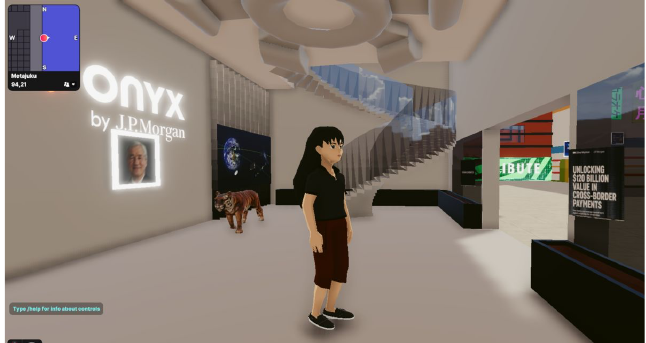
Figure 35: JP Morgan in Decentraland Metaverse Law Enforcement in the Metaverse: Law enforcement agencies are recognising the potential of the metaverse, and INTERPOL has recently established its headquarters within this virtual environment to train and educate its staff worldwide [54] [figure 36].